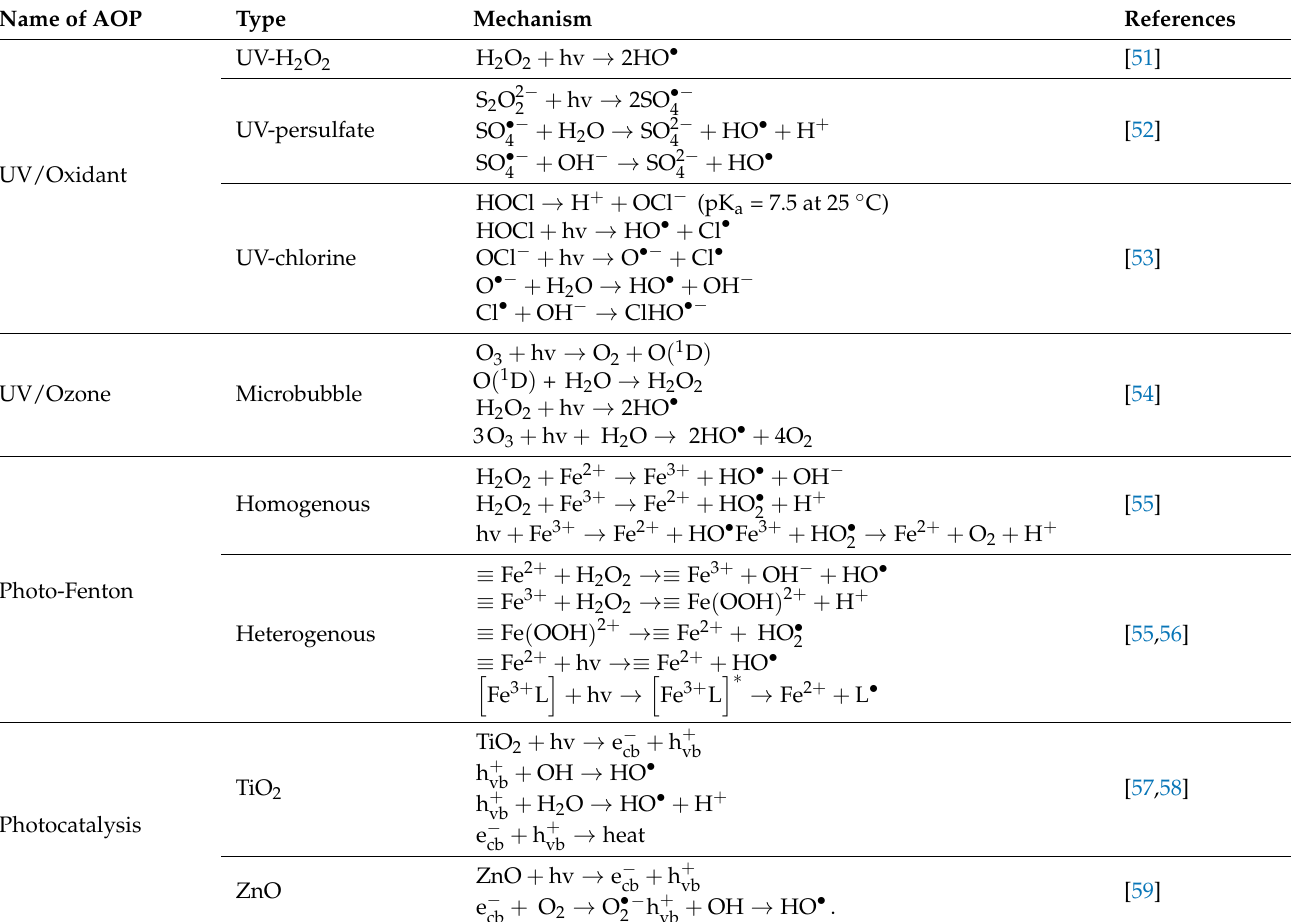
Table 2. Mechanism of conventional light-driven